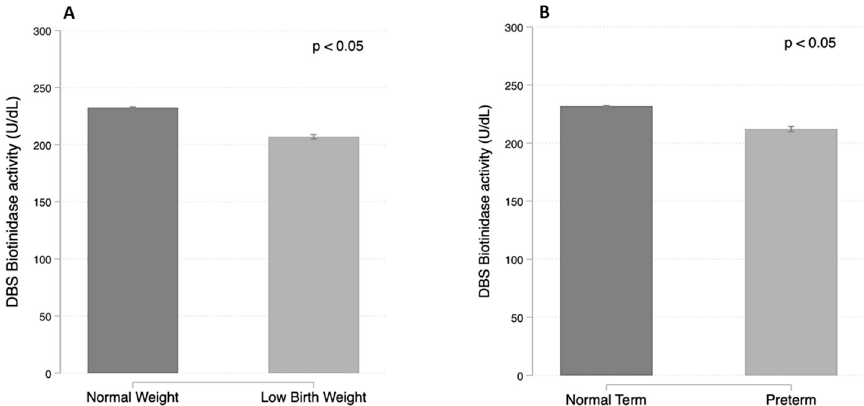
Figure 4. DBS biotinidase activity in relation to the birth weight ( A ) and to the pregnancy term ( B ).